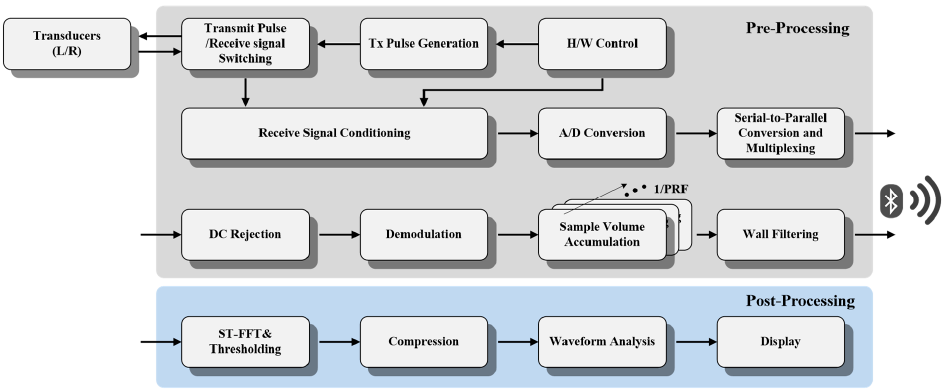
Figure 1. Functional block diagram of the wireless carotid wearable ultrasound Doppler system; ST-FFT: Short-time fast Fourier transform; PRF: Pulse-repetition frequency.